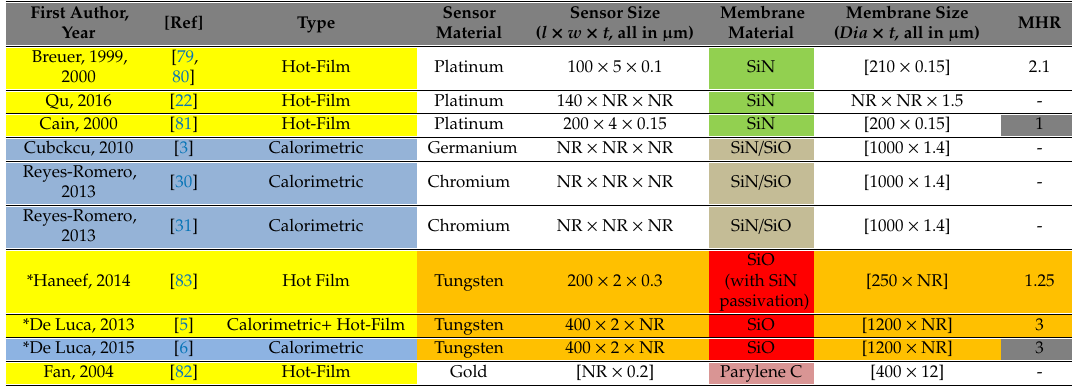
Table 4. MEMS Thermal Flow Sensors with Circular Membranes.